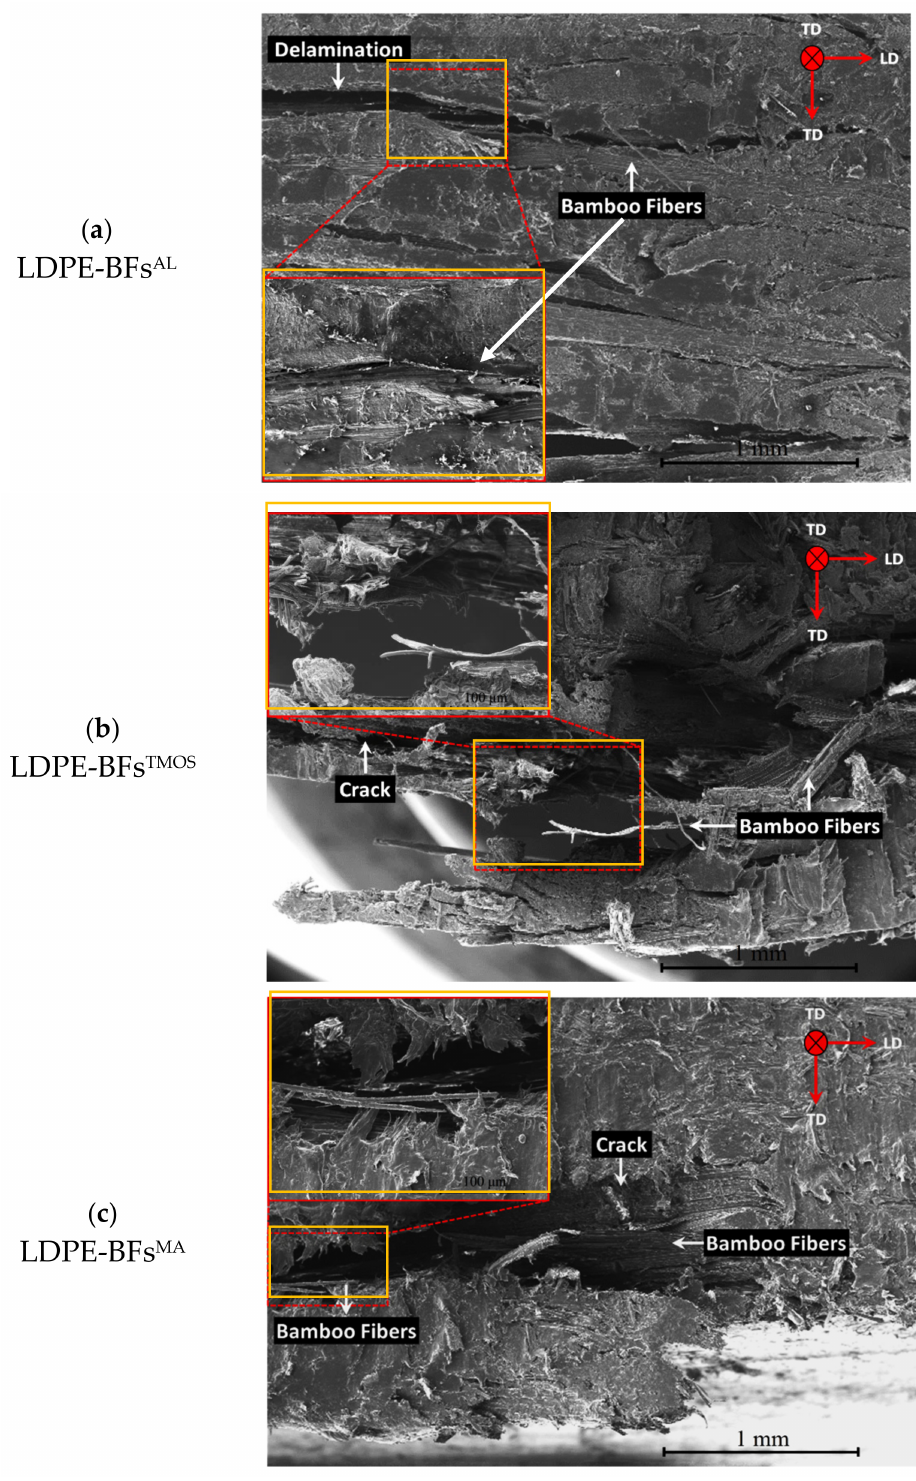
Figure 10. SEM images showing the fracture modes subjected to flexural loading: ( a ) fracture of LDPE-BFs AL shows a delamination of the matrix longitudinal to the fiber, ( b ) fracture of LDPE-BFs TMOS shows pullout of fibers from the matrix and a ductile fracture of the matrix, and ( c ) fracture of LDPE-BFs MA shows pullout of fibers from the matrix, crack propagation in the matrix and ductile fracture of the